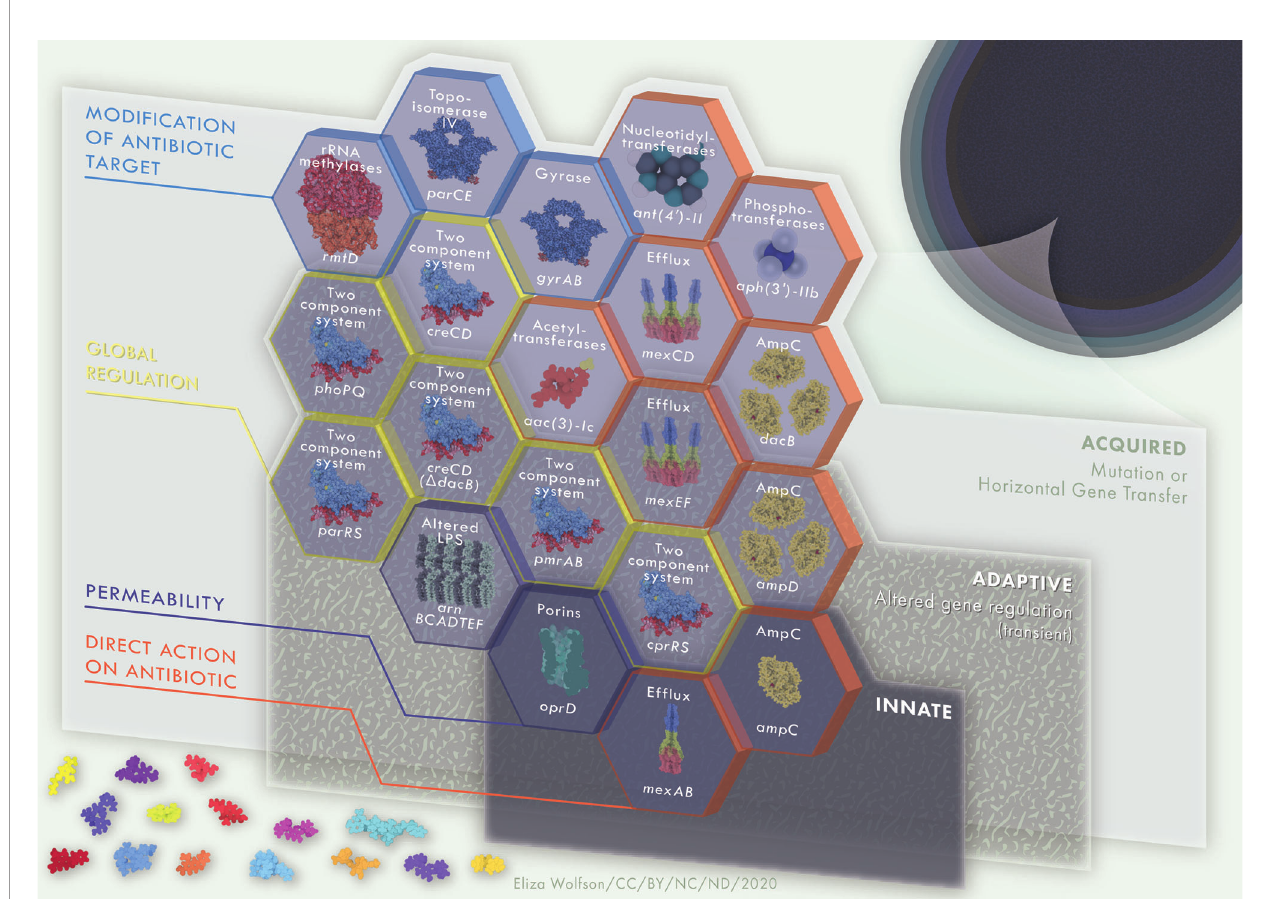
FIGURE 3 | Multi-layered, interacting resistance mechanisms in P. aeruginosa . Innate (intrinsic) resistance mechanisms are encoded in the core genome of the organism, such as low outer membrane permeability, Mex-type ef fl ux pumps and AmpC b -lactamase. Collectively, these comprise basal level resistance to antimicrobials, a foundation on which a variety of adaptive and acquired mechanisms of resistance may serve as building blocks to further enhance AMR in P. aeruginosa . Adaptive resistance mechanisms, including two-component regulatory systems, are environmentally dependent and will be expressed under certain conditions only. Mechanisms of resistance that are acquired, such as antibiotic modifying enzymes or mutations leading to antibiotic target modi fi cations are strain dependent. The building blocks of innate, adaptive and acquired mechanisms of resistance contribute to a strong and multi-faceted protection against antimicrobial activity. Hexagon building blocks of resistance mechanisms are colored according to mechanism type; direct action on antibiotic, permeability, global regulation, modi fi cation of antibiotic target. Upper labels on hexagon building blocks describe resistance mechanism whilst lower labels de fi ne examples of each such systems. Protein and drug structures were generated with Protein Imager (Tomasello et al.,